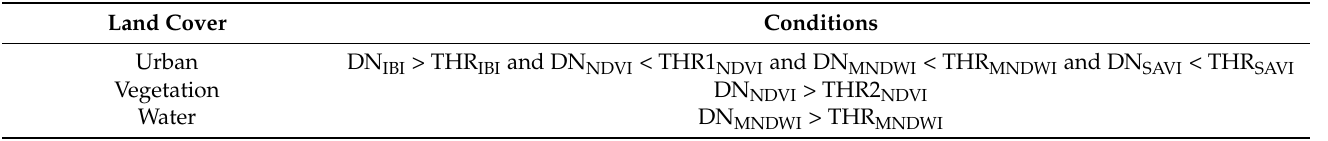
Table 1. The conditions to determine the land cover classes for Landsat 8 OLI images. Land Cover